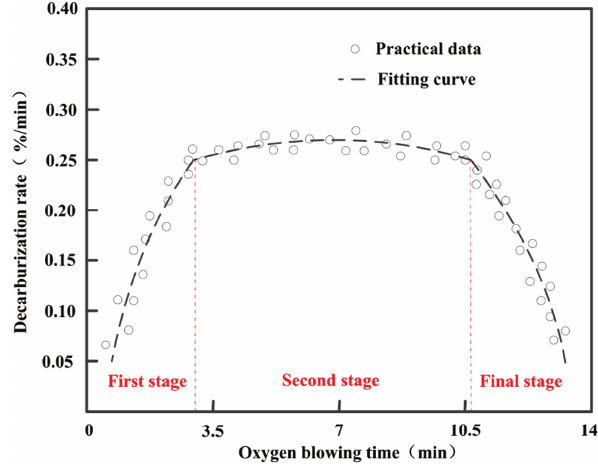
Figure 1: Classical three-stage decarburization theory for BOF steel- making